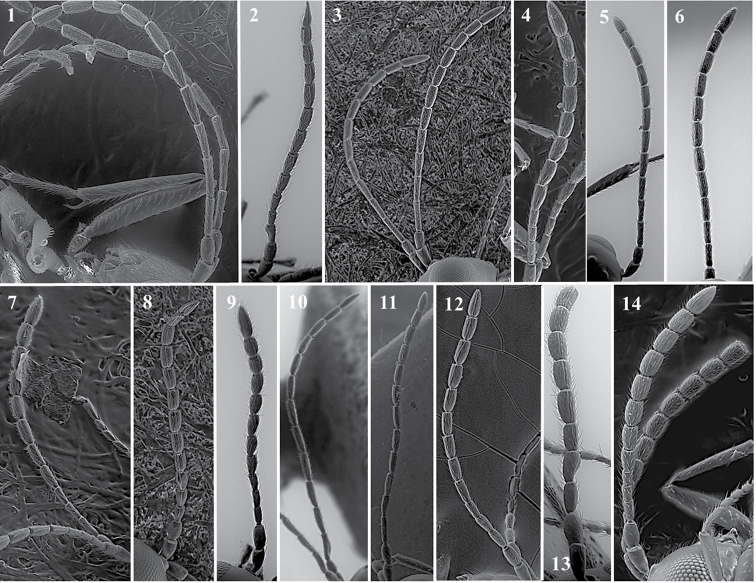
Alloxysta antennae. A.alpina (1); A.areeluckator (2); A.buffingtoni (3); A.franca (4); A.huberi (5); A.neartica (6); A.pili (7); A.petchabunensis (8); A.texanae (9); A.vicenti (10) ; A.viellae (11); A.corta (12); A.palearctica (13); A.pascuali (14); A.nottoni (15).